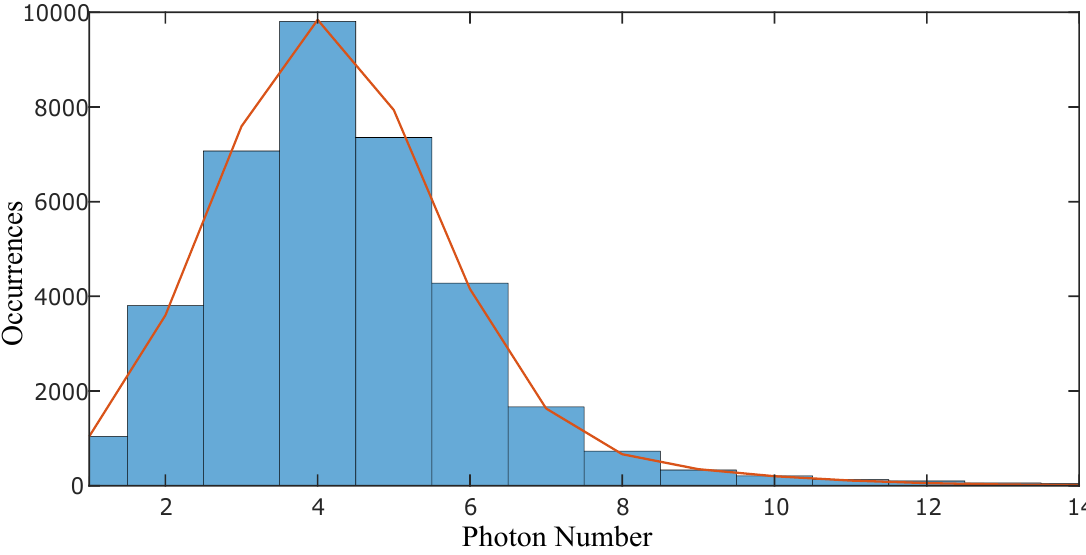
Figure 4. Histogram of intensity counts for a pulse arriving at a fixed value of the camera’s rise time. The histogram is fitted with a function which is a summation of a Gaussian and a Poisson function. The Gaussian function is due to the background while the Poisson distribution is due to the sparse photon counts of the signal.